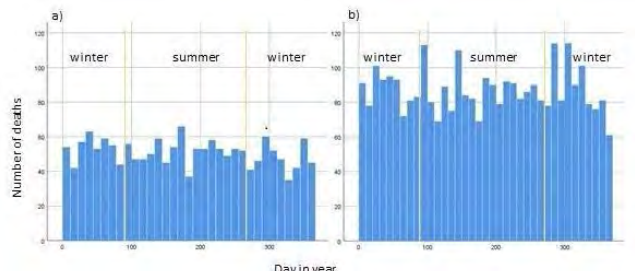
Figure 1: Distribution of deaths in allogeneic (a) and autologous (b) HSCT patients during the